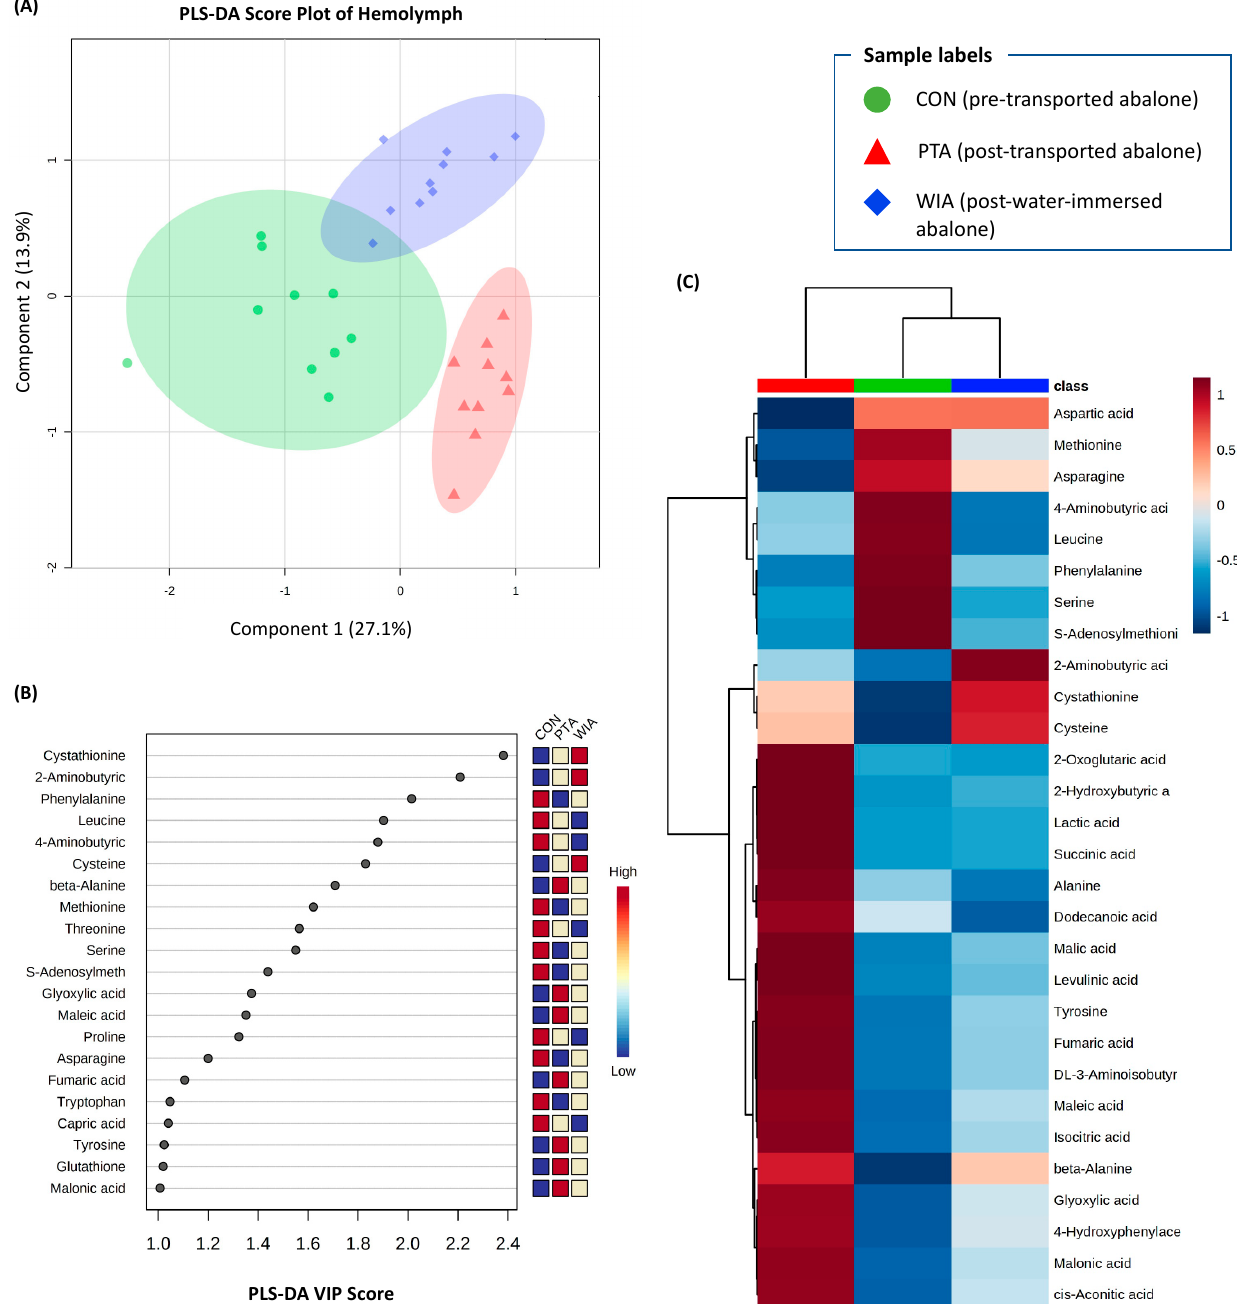
Figure 1. Effects of transport and re-immersion on normalised metabolite profiles of abalone haemolymph. ( A ) PLS-DA score plots. ( B ) Relative abundance of metabolites with VIP scores greater than 1.0. ( C ) Heatmap of 29 metabolites that differed among treatments. The colour bars in the PLS-DA VIP score plot and heatmap show the relative abundance of metabolites (stronger blue: lower abundance; stronger red: higher abundance).